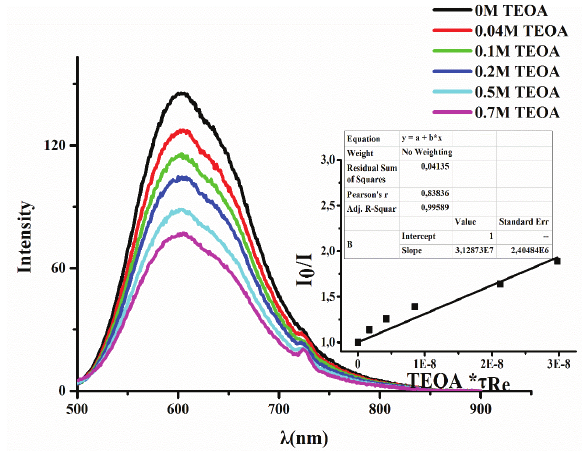
bpy] with added [TEOA] 3